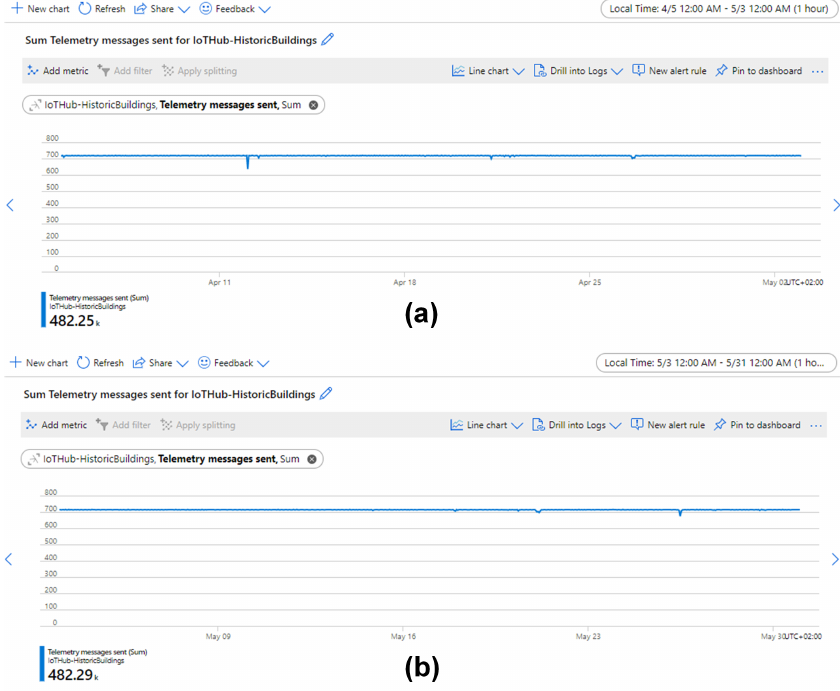
Figure 12. Hourly aggregated metrics for messages sent from edge to IoT Hub between 5 April and 31 May. The total number of sent messages was ∼ 964,540. Among them, ( a ) ∼ 482,250 messages were sent between 5 April and 3 May and ( b ) ∼ 482,290 messages were sent between 3 May and 31 May.